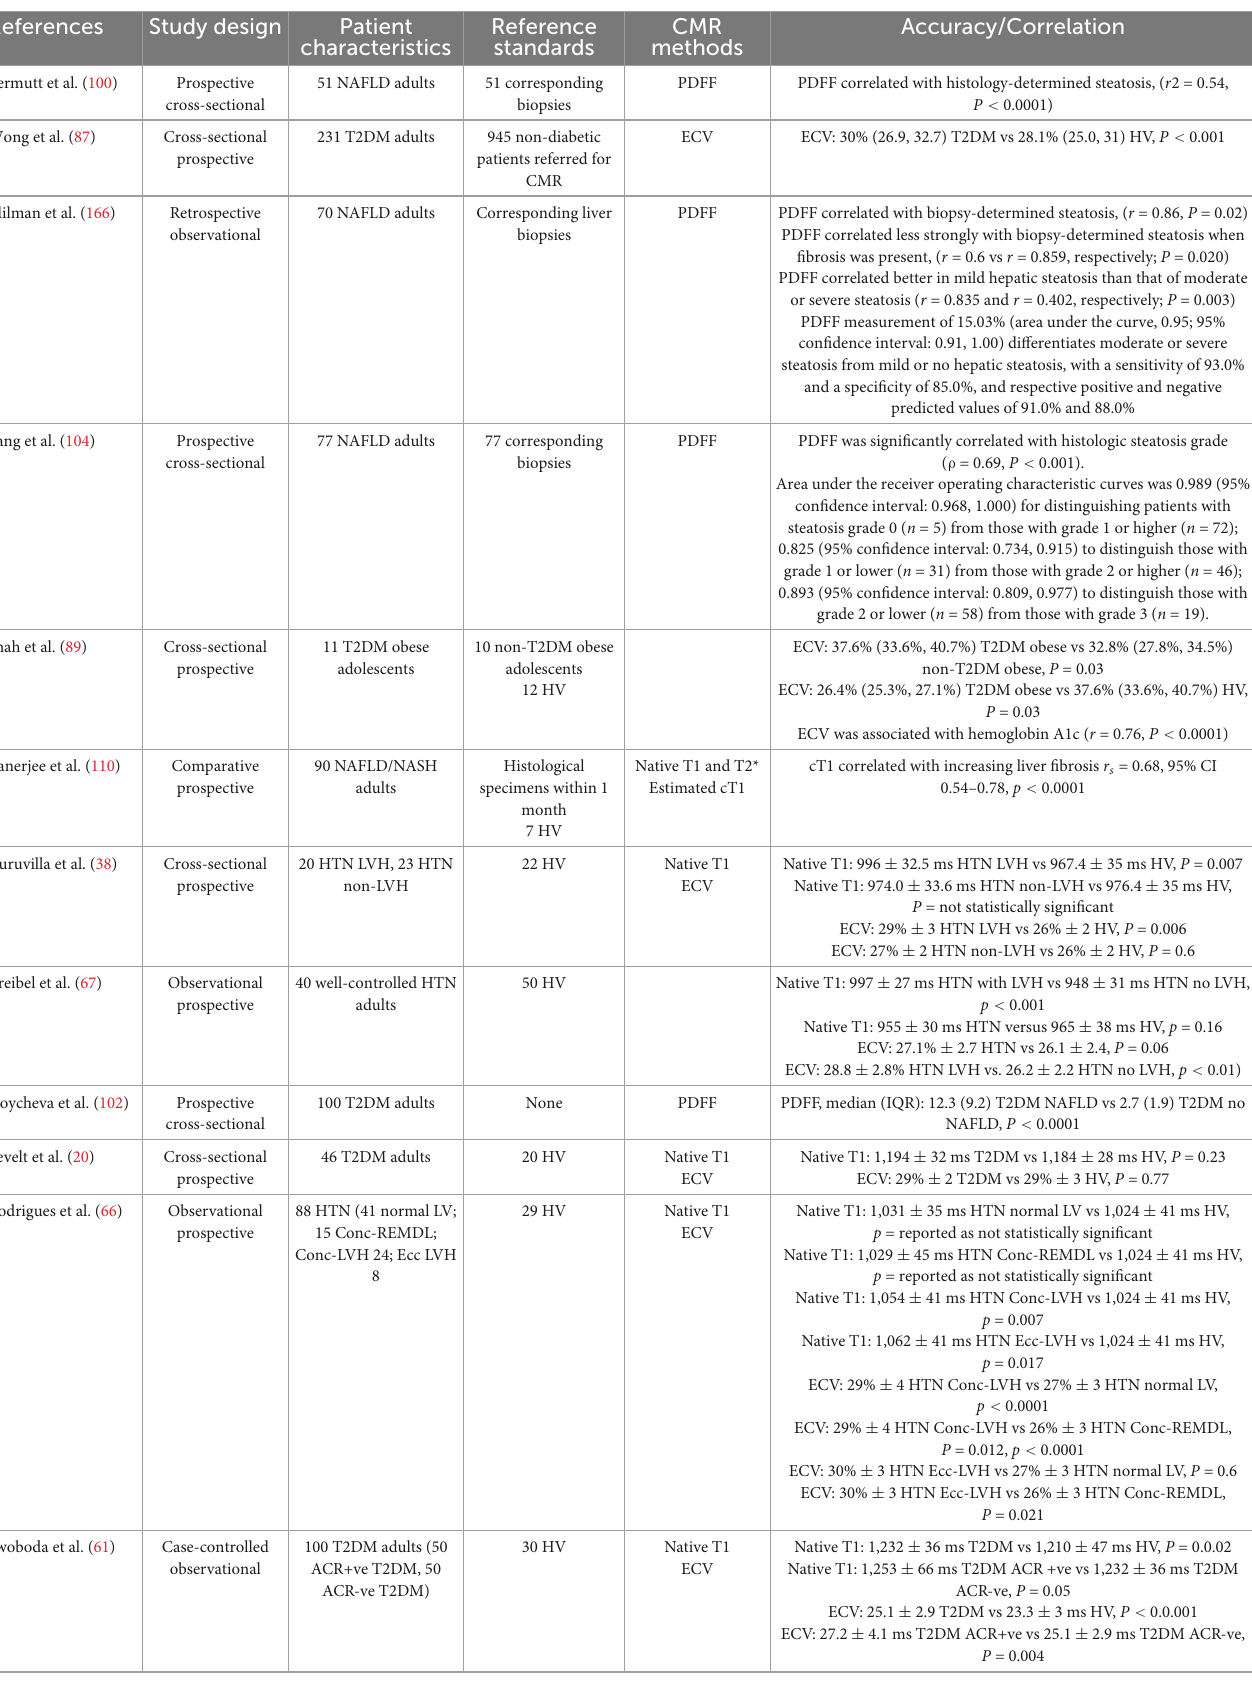
TABLE 1 In vivo CMR studies with conventional single-parameter mapping techniques in patients with cardiometabolic